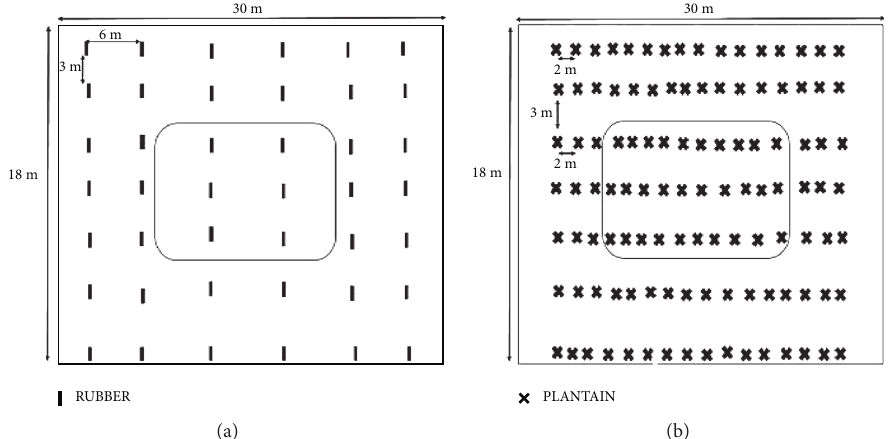
Figure 3: Population of rubber and plantain under the sole cropping systems. The marked plants were the selected plants for the data. (a) Sole rubber. (b) Sole plantain.